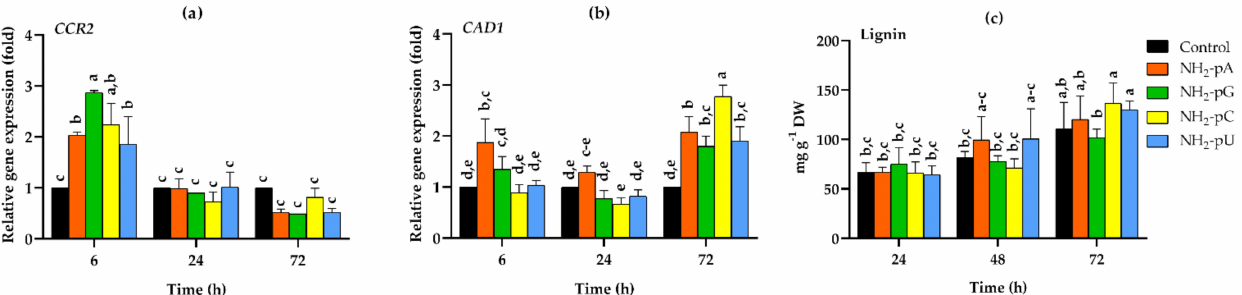
Figure 8. Expression of cinnamoyl-CoA reductase ( CCR2) , cinnamyl alcohol dehydrogenase ( CAD1 ), and lignin content in cells of Vitis vinifera cv. Monastrell treated with 5 µ M nucleoside 5 (cid:48) -phosphoramidates. ( a ) CCR2 , cinnamoyl-CoA reductase ( b ) CAD1 , cinnamyl alcohol dehydrogenase ( c ) lignin content. Total RNA was reverse-transcribed into cDNA and used as a template for real-time quantification PCR reaction as described in the Section 4. Specific primers were designed for CCR2, CAD1, and EF α 1 (elongation factor 1-alpha, which was used as an endogenous control). The expression level of CCR2 and CAD1 in the control cells (no nucleotide added) was set to 1. The lignin content was determined as described in the Section 4. Values represent the mean ± standard deviation of the three replicates. Values without a common letter were significantly different according to ANOVA and Tukey’s HSD multiple range test ( p ≤